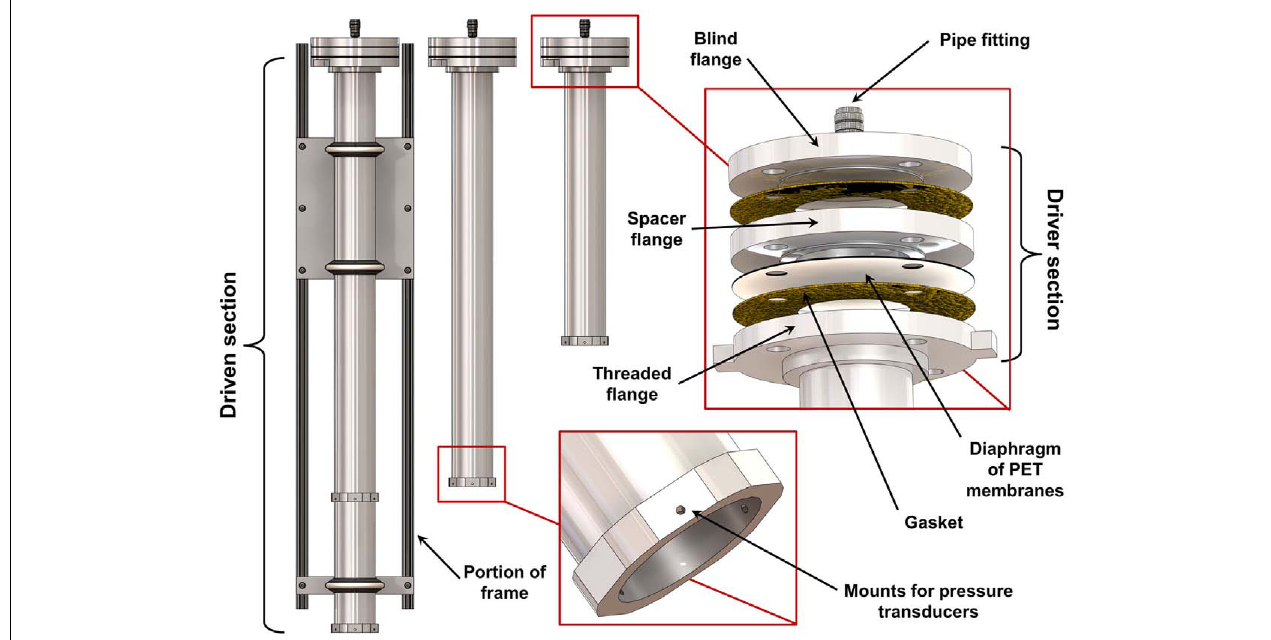
FIGURE 1 | Schematic of the set of three shock tubes showing the details of the design and construction of the driver and driven sections.